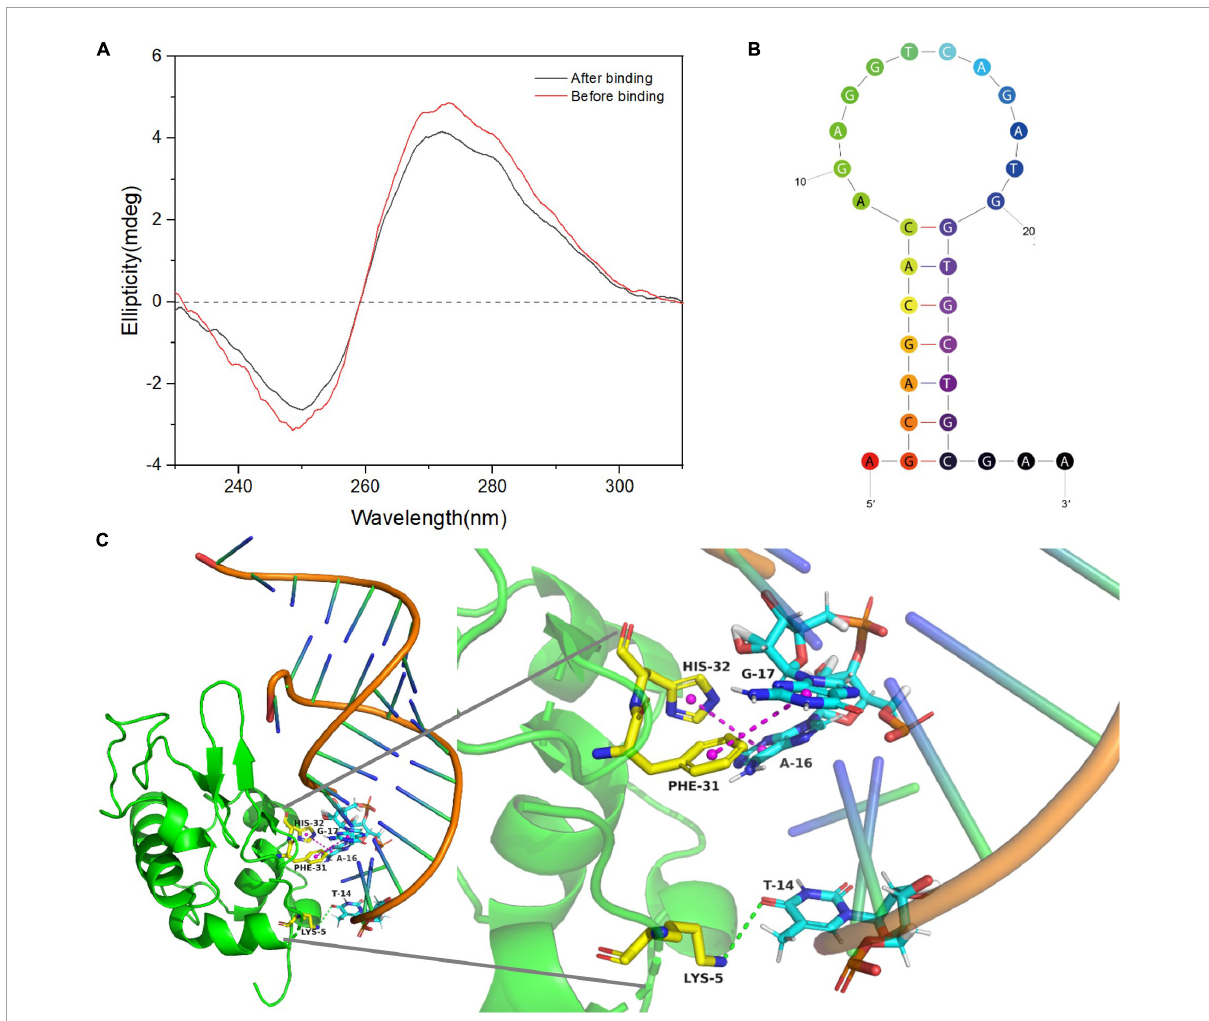
FIGURE2 Binding mechanism of α -lactalbumin ( α -La) and LA-1t. (A) Circular dichroism of LA-1t before and after binding; (B) Secondary structure of LA-1t predicted by UNAfold online software; (C) The result of molecular docking between aptamer α -La and LA-1t.